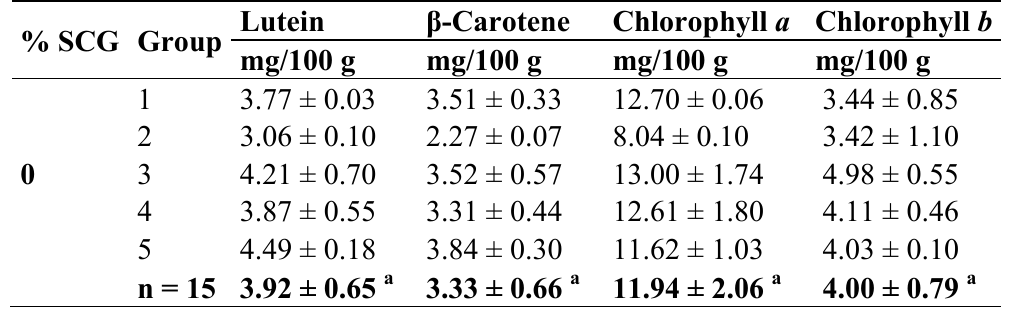
Table 1. Detail on individual carotenoids and chlorophylls amounts in lettuce grown with